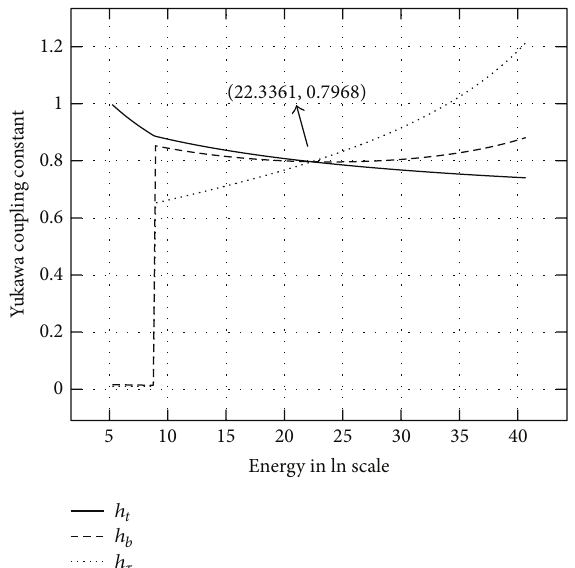
Figure 3: Third-generation Yukawa couplings unification for 𝑚 𝑠 = 7 TeV, (𝑒 22 . 3361 = 5 . 0175 × 10 11 ) GeV.